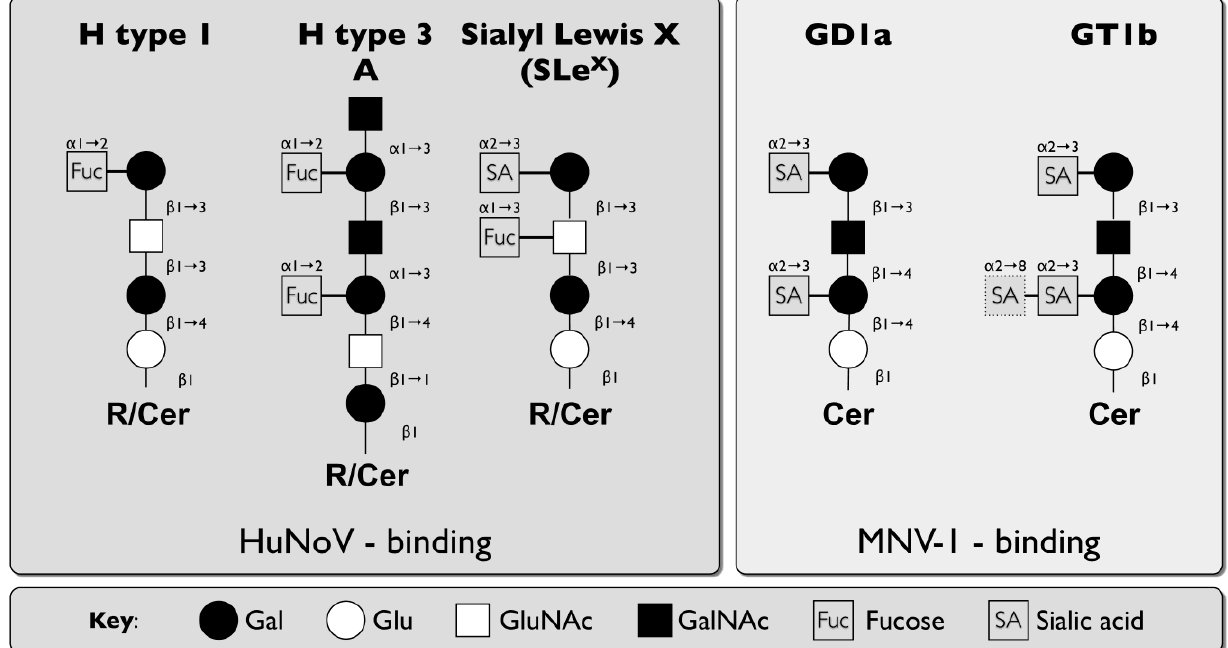
Figure 3. Comparison of some discussed carbohydrate structures used during attachment of human and mouse NoV. Schematic representation of the HuNoV attachment